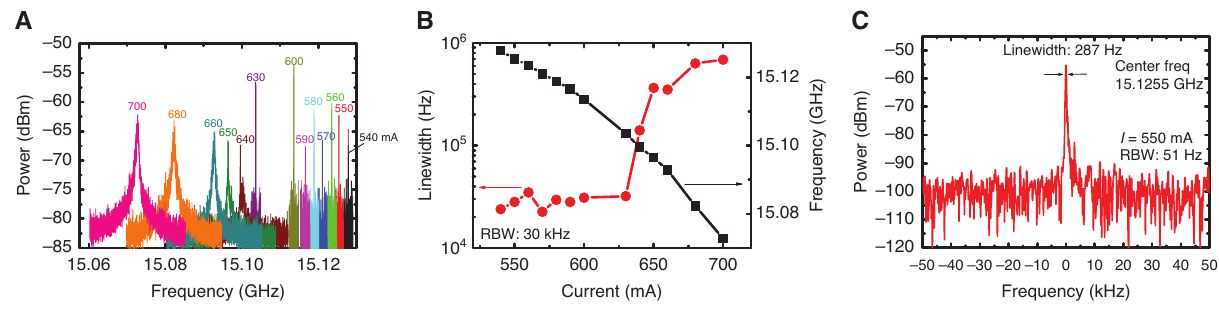
Figure 15: Frequency comb performance. (A) Beat-note spectra of a 3-mm-long, 12- μ m-wide, DFB/FP THz DFG-QCL biased with different currents at the heat sink temperature of 78 K. The currents are indicated on top of each spectrum. (B) Beat-note linewidth and frequency as functions of currents. (C) Beat-note spectrum measured with bias current of 550 mA at 78